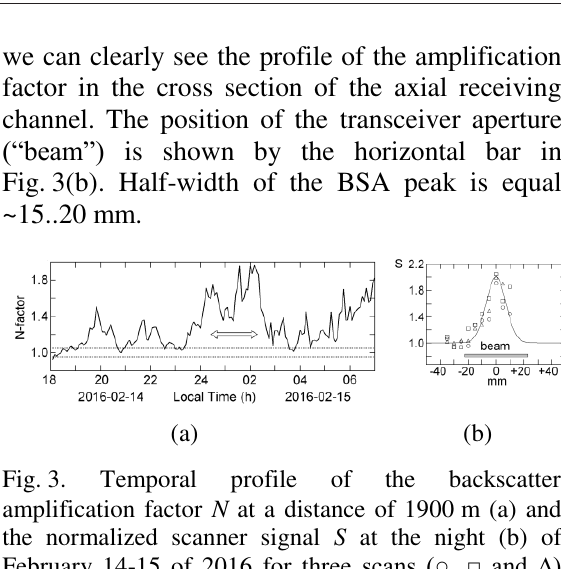
Fig. 2. Schematic of the experiment: lidar 1 and topographic target 2 (top), image jitter sensor: diffuse luminous white disk 3 on black and teleobjective with CCD camera 4 (center), probing path between buildings 5 and 6, and rough site plan (bottom).